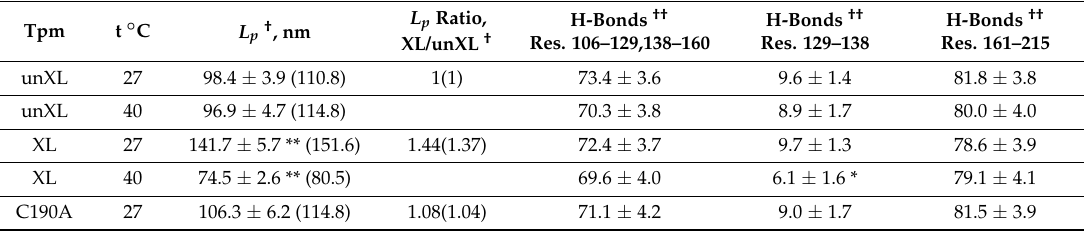
Table 1. The persistence length L p of the middle part of Tpm and the number of the main chain H-bonds estimated from MD simulations.